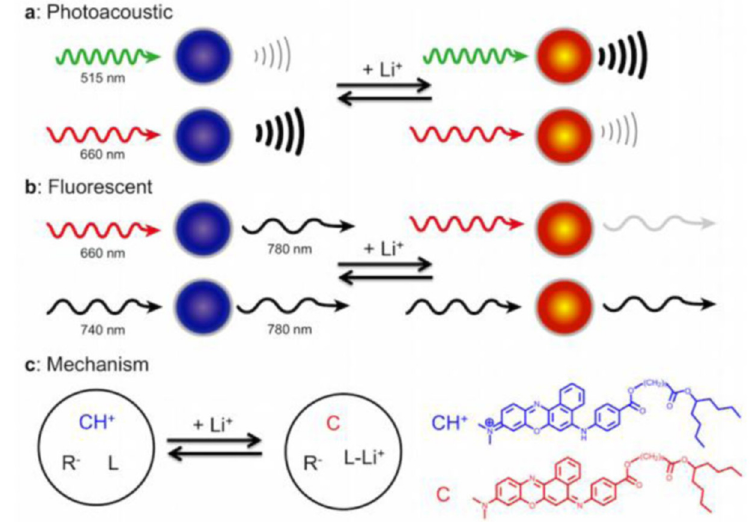
Figure 6. Photoacoustic ( a ) and fluorescent ( b ) imaging techniques were employed to monitor nanosensors used for detecting lithium. In photoacoustic monitoring, two wavelengths were used to interrogate the chromoionophore embedded in the sensors, and the photoacoustic waves from each wavelength changed as lithium concentration varied. In fluorescent imaging, a near-IR fluorophore was added to the sensors and the intensity of FRET from the chromoionophore to the near-IR dye changed with different lithium concentrations. ( c ) The fundamental mechanism of the lithium response was lithium extraction by an ionophore (L) into the core of the nanosensor, which deprotonated a chromoionophore (CH + ), changing the optical properties of the nanosensor. An additive (R) balanced the charge inside the sensor (modified with permission from Cash et al., ACS Nano , 2015 [67]). Table 2. Studies investigating optical techniques for lithium therapeutic monitoring.